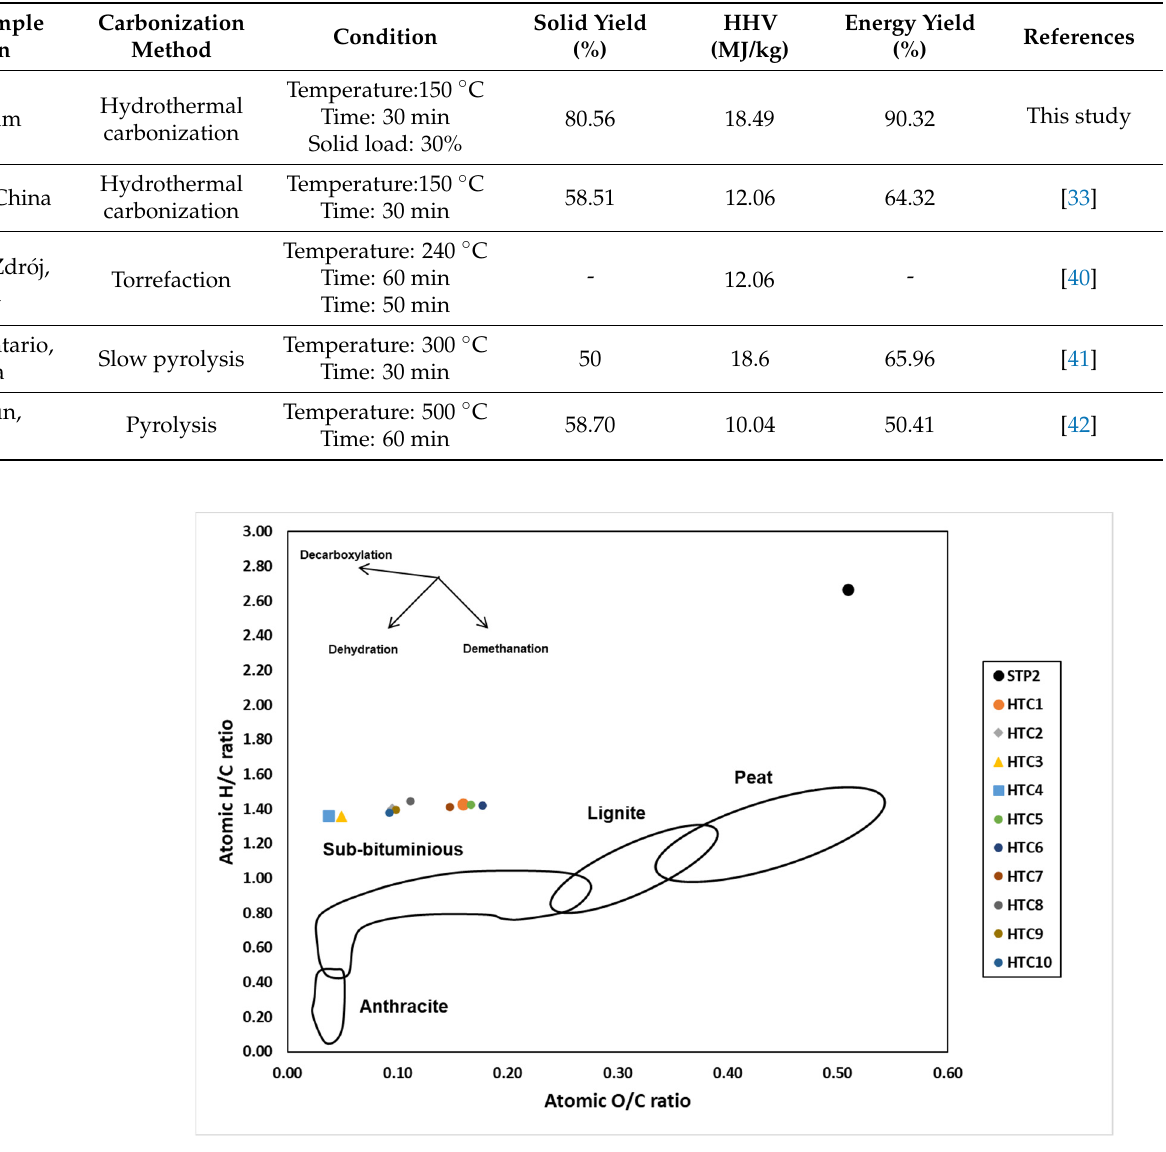
Figure 4. Van Krevelen diagram of raw sewage sludge and hydrochar produced at different HTC